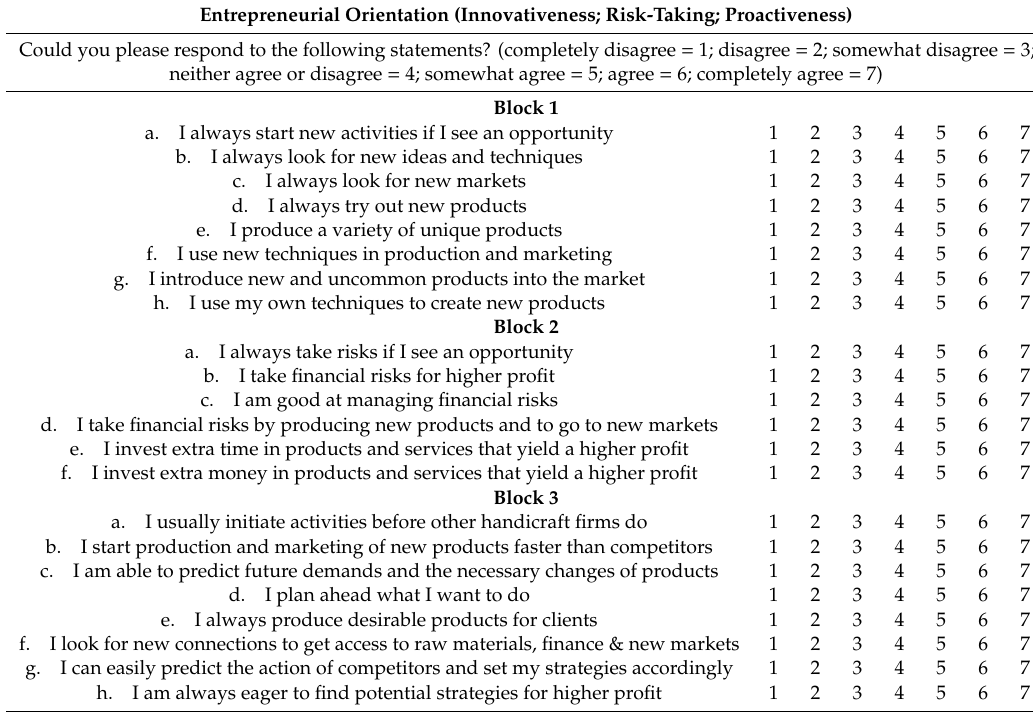
Table A1. Measurement of entrepreneurial orientation. Entrepreneurial Orientation (Innovativeness; Risk-Taking;